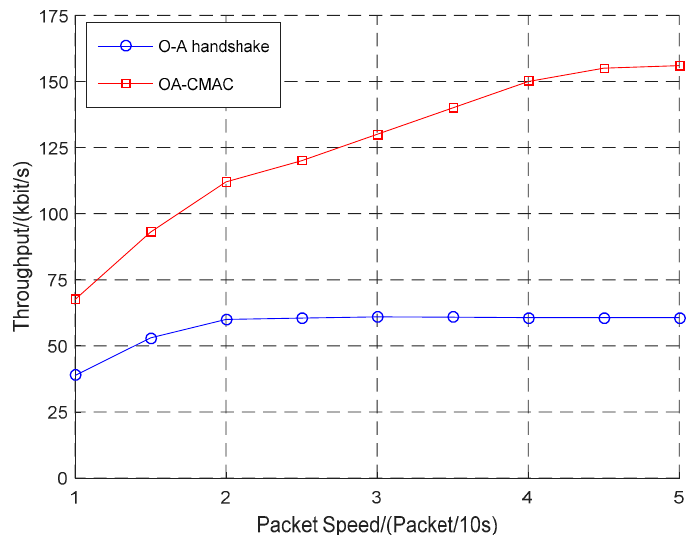
Figure 7. Comparison of three protocol throughputs when the optical handshaking success rate was 80%.